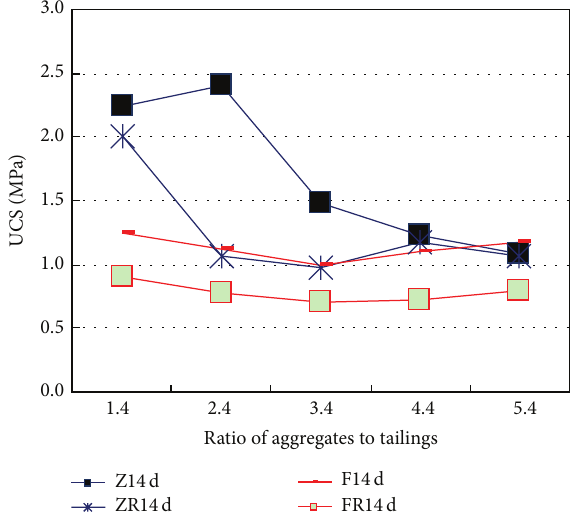
Figure 7: Backfill slurry slump using 19% cement content.